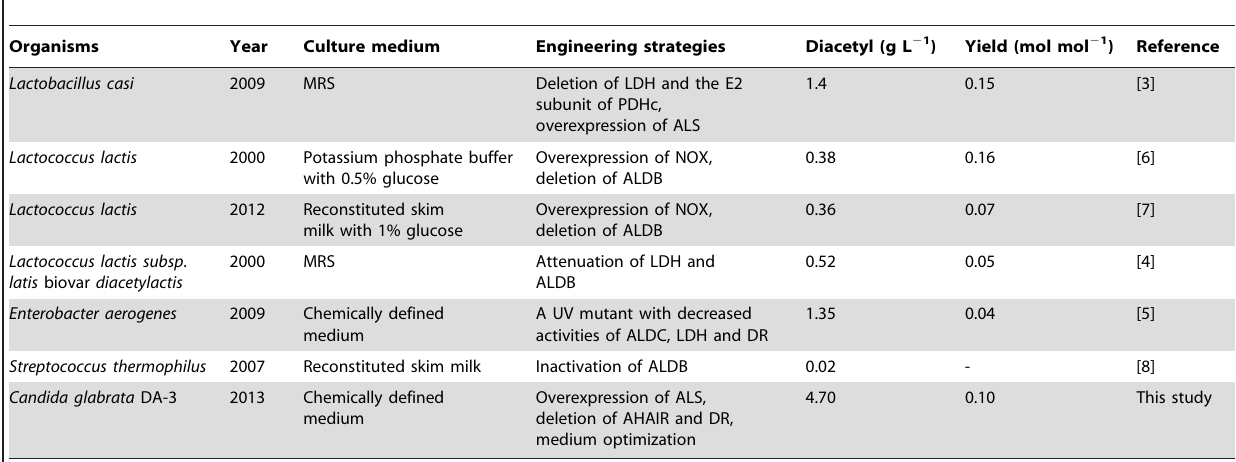
Table 1. Comparison of diacetyl production using different microorganisms in terms of culture medium, engineering strategies, and